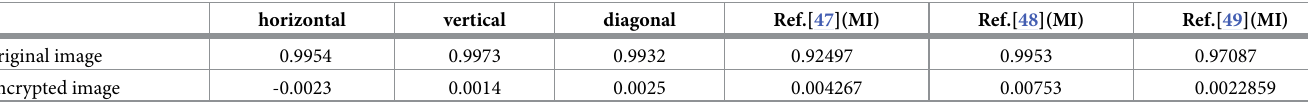
Table 14. Medical image correlation coefficient comparison table.